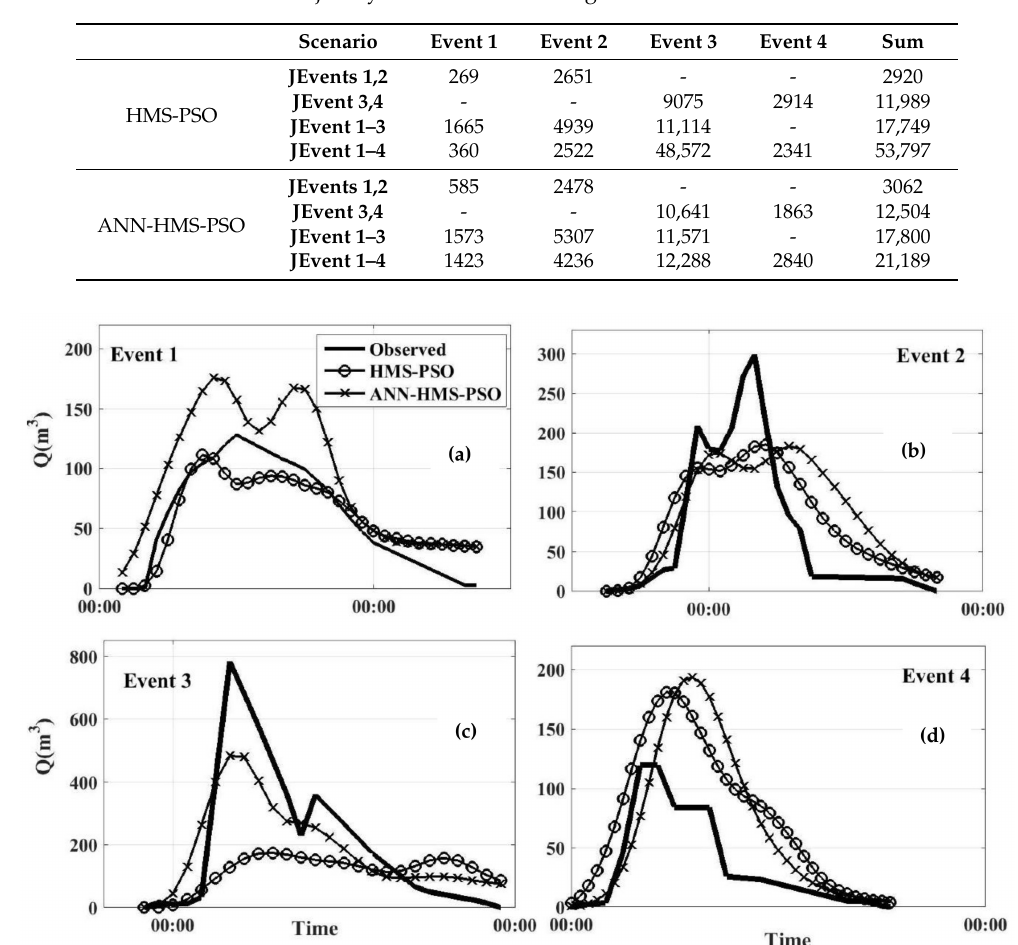
Figure 10. Observed and simulated discharge hydrographs for jointly event scenario (JEvent 1–4) occurred on ( a ) 19 September 2004; ( b ) 6 May 2005; ( c ) 9 August 2005; and ( d ) 8 October 2005